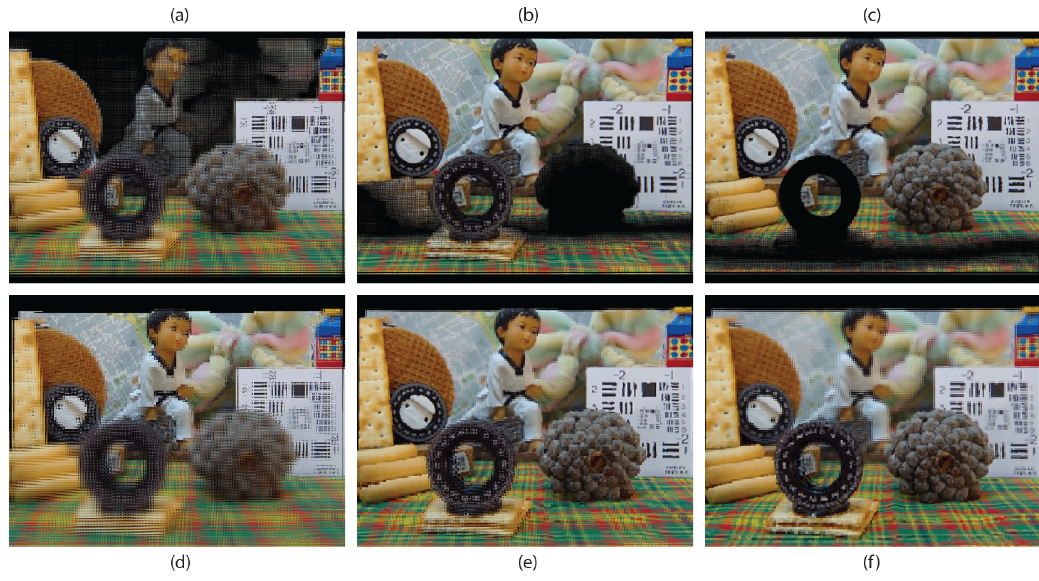
Figure 7. Top row: Images obtained with the technique of [12]. Bottom row: Images obtained with the proposed technique. ( a , d ) Reference plane at the background; ( b , e ) reference plane at the middle; and ( c , f ) reference plane at the